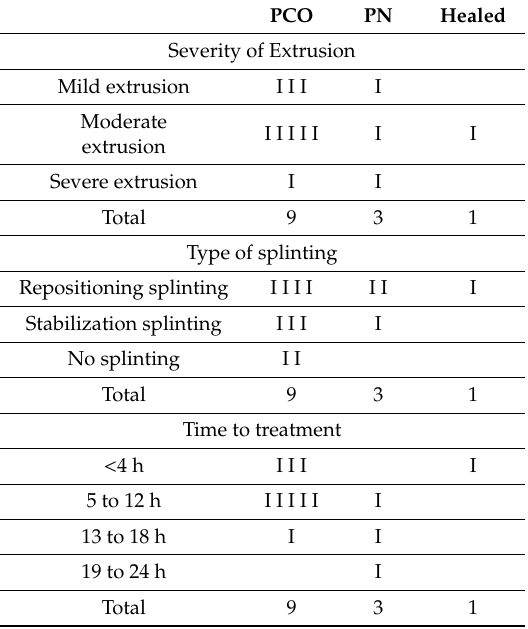
Table 4. The table shows the analysis of pulp consequences with respect to covariates (mm of extrusion, type of splinting and time to treatment).